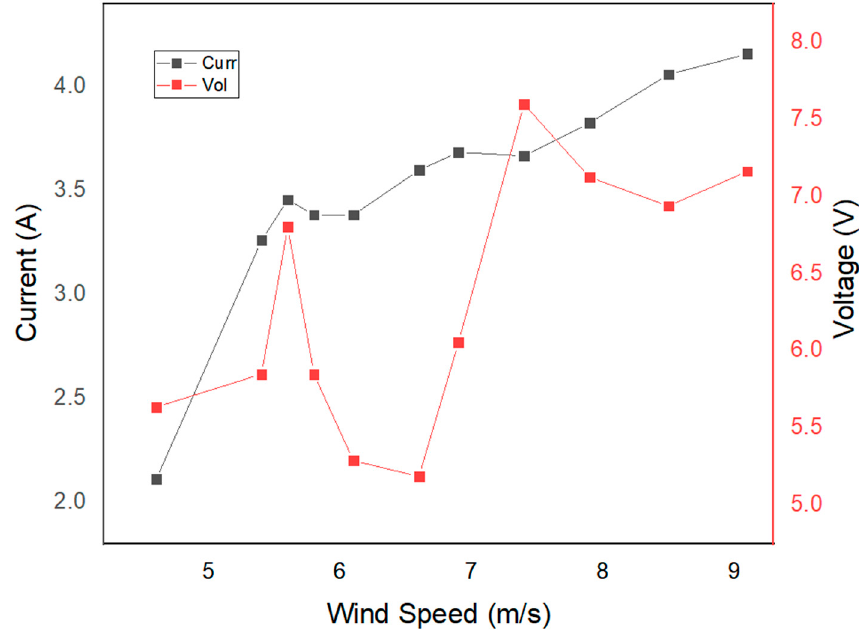
Figure 12. Current and voltage.